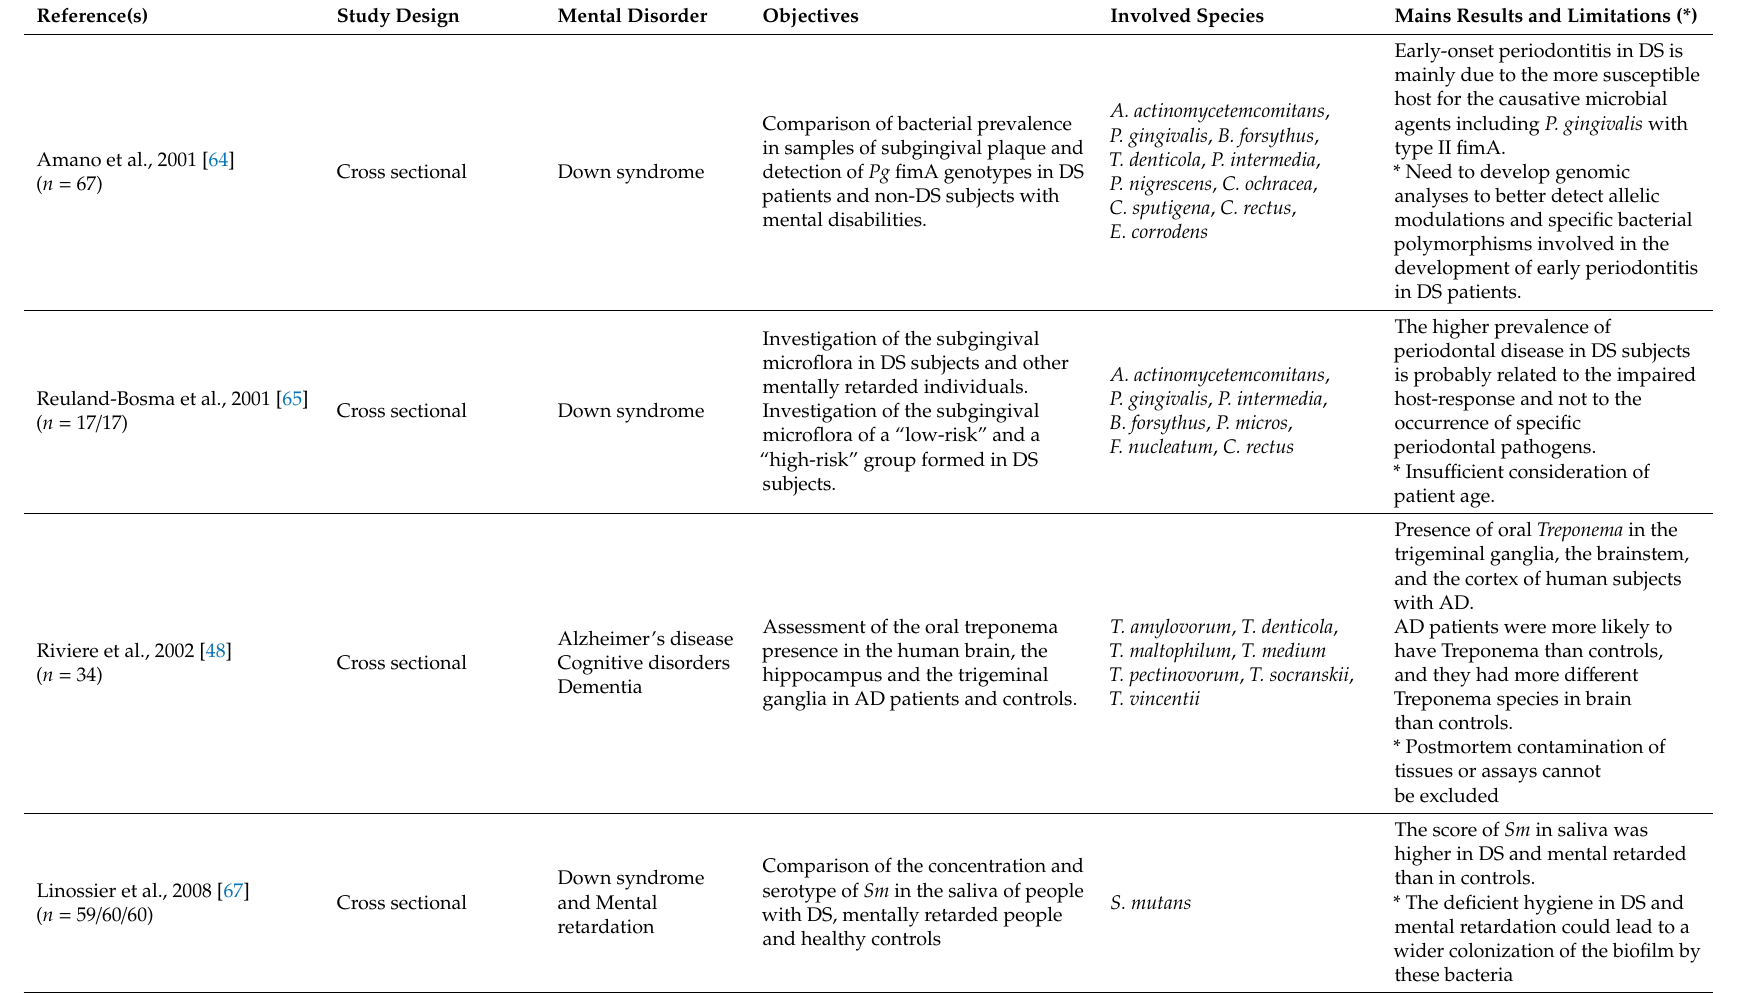
Table 1. Summary of studies that have examined the relationship between oral microbiota and mental